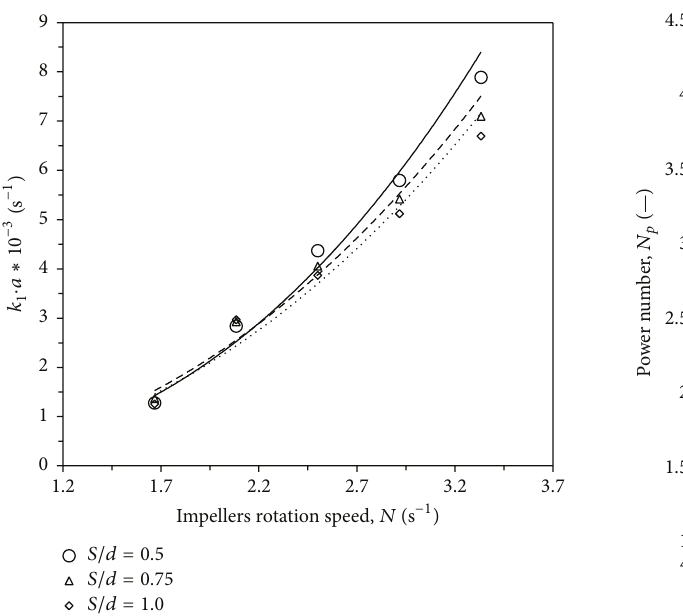
Figure 2: Spacing effect on the oxygen mass transfer coefficient.